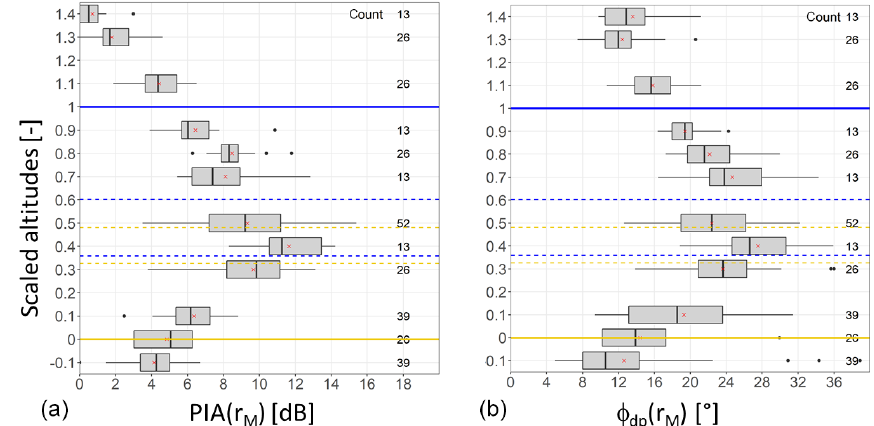
Figure 12. Boxplots of the PIA and φ dp values within the ML as a function of the scaled altitude ( a and b , respectively) for the stratiform event of 4 January 2018. The horizontal blue and orange continuous lines represent the ML top and bottom, respectively; the broken horizontal blue and orange lines give the 10% and 90% quantiles of the scaled altitudes of the Z h and ρ hv peak distributions, respectively.